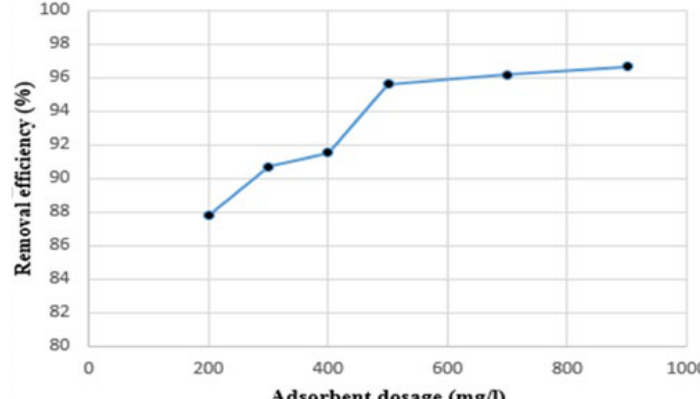
Fig. 8. Efficacy of palladium oxide nanoparticles dose on cadmium removal process Fig 8. Efficacy of palladium oxide nanoparticles dose on cadmium removal process